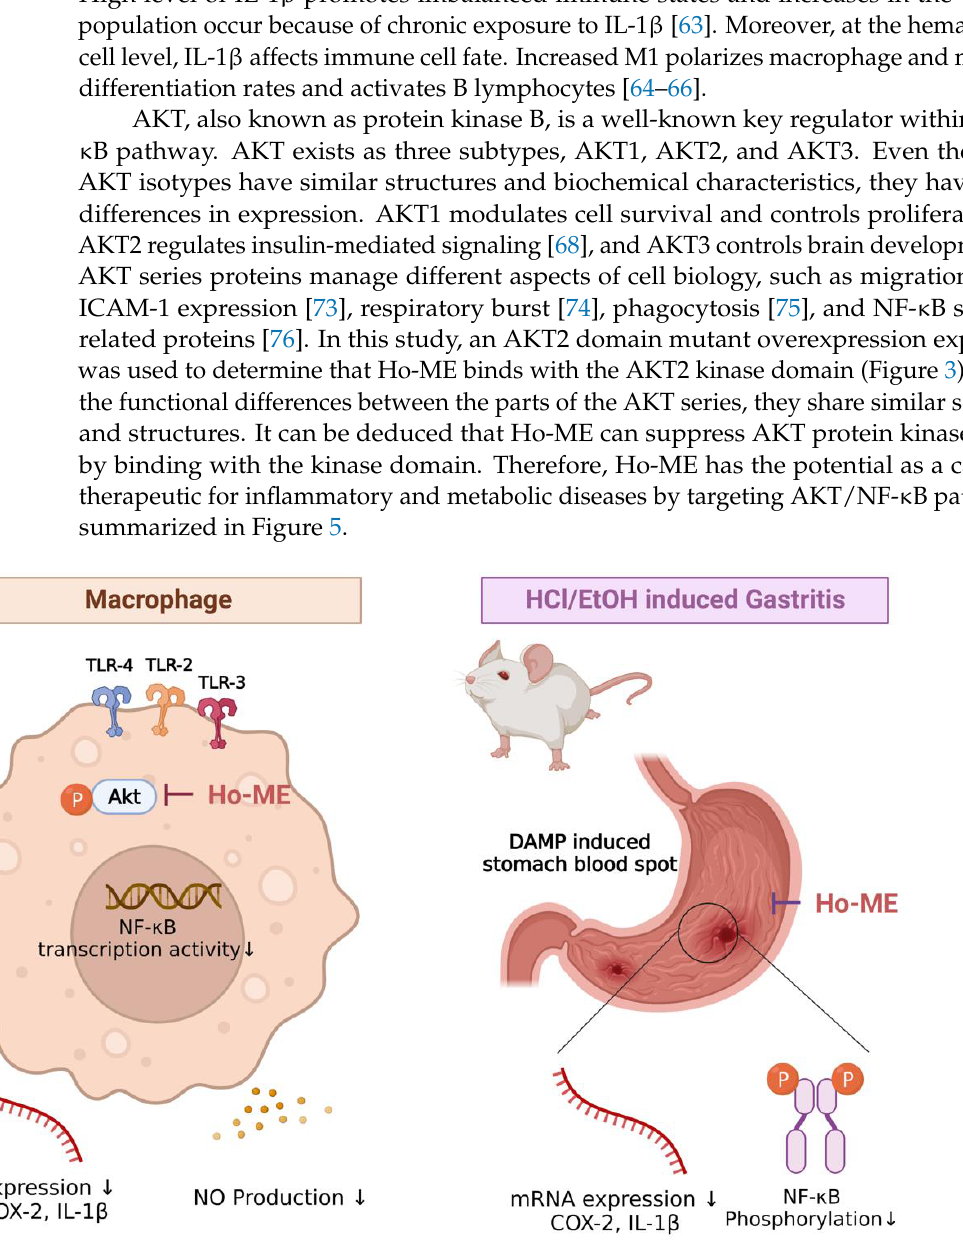
Figure 5. Putative scheme of AKT-targeted anti-inflammatory response by Ho-ME at the molecular, cellular, and in vivo levels.